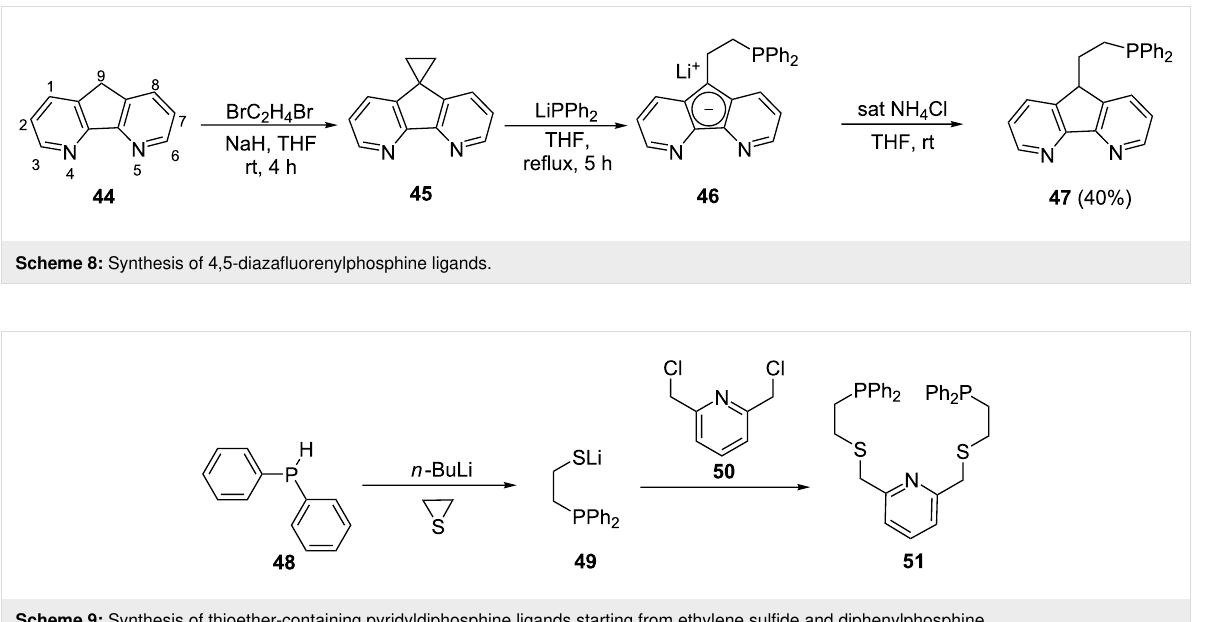
Scheme 9: Synthesis of thioether-containing pyridyldiphosphine ligands starting from ethylene sulfide and